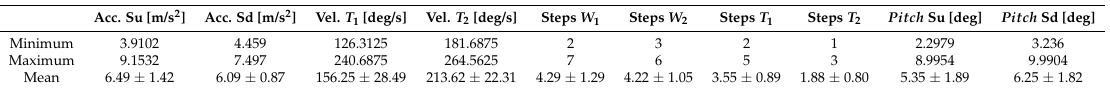
Table 5. Characteristics obtained after the implemented segmentation of the activities performed by the young subjects during the TU & Go test.